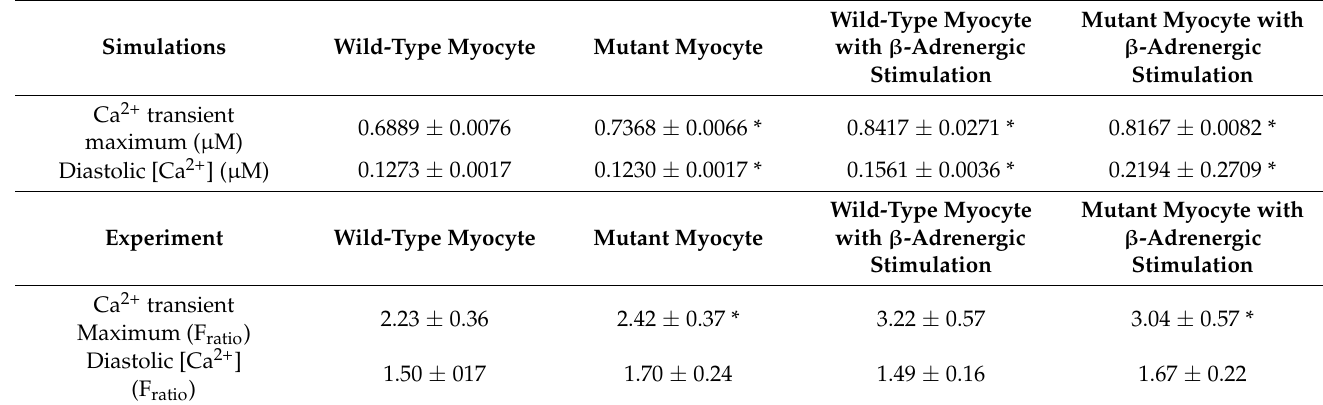
Table 3. Properties of Calcium Transients at 1 Hz